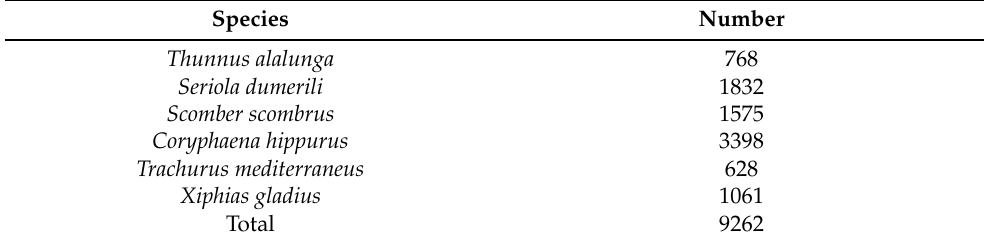
Table 5. Number of images per species in the Symbiosis-NCC dataset, obtained from the Symbiosis dataset after filtering in order to have Normalized Cross-Correlation below 50%.